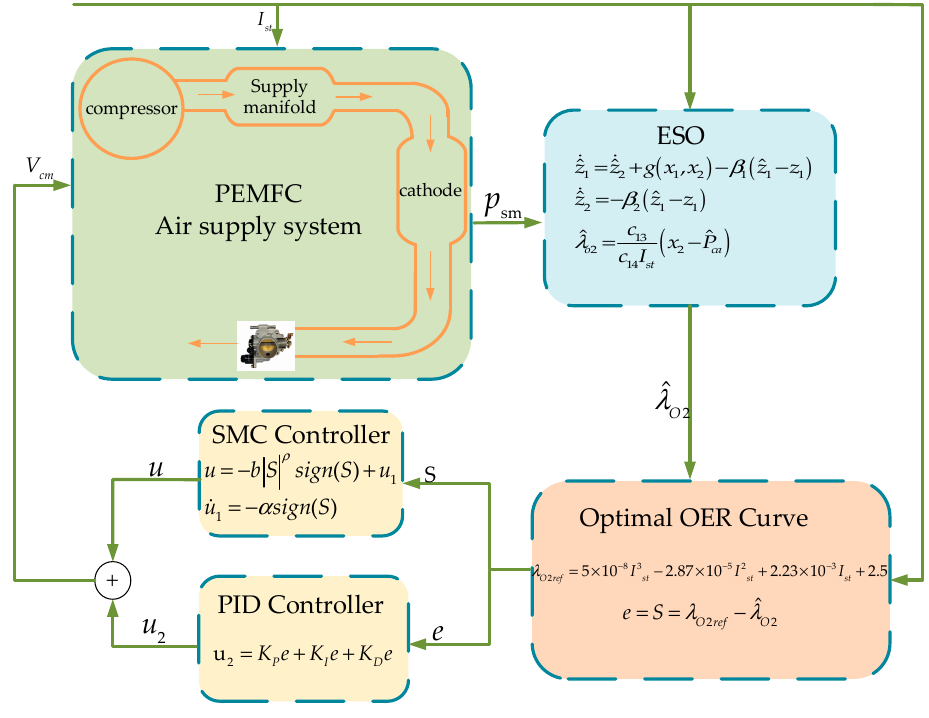
Figure 4. Flow chart of the OER control method.